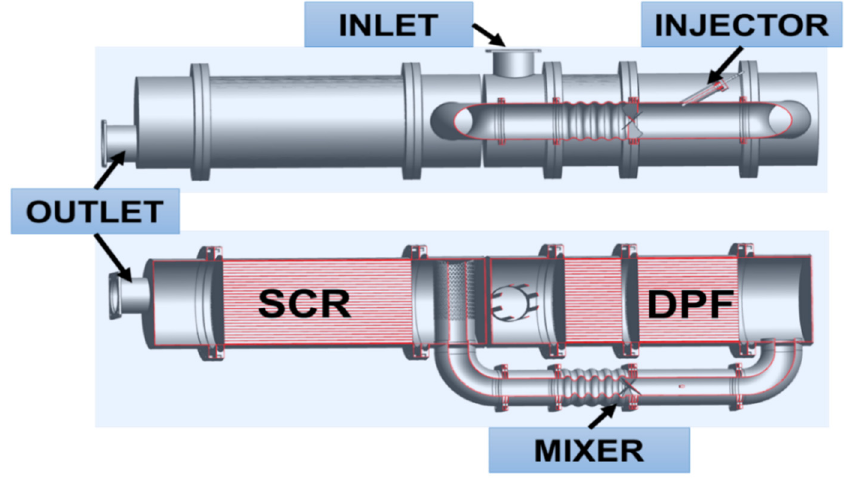
Figure 11. Simulation geometry of the commercial SCR system in the D6CC.